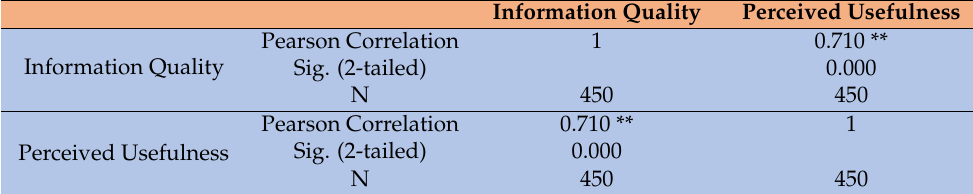
Table 9. Results of correlation analysis for hypothesis 4 (H4).